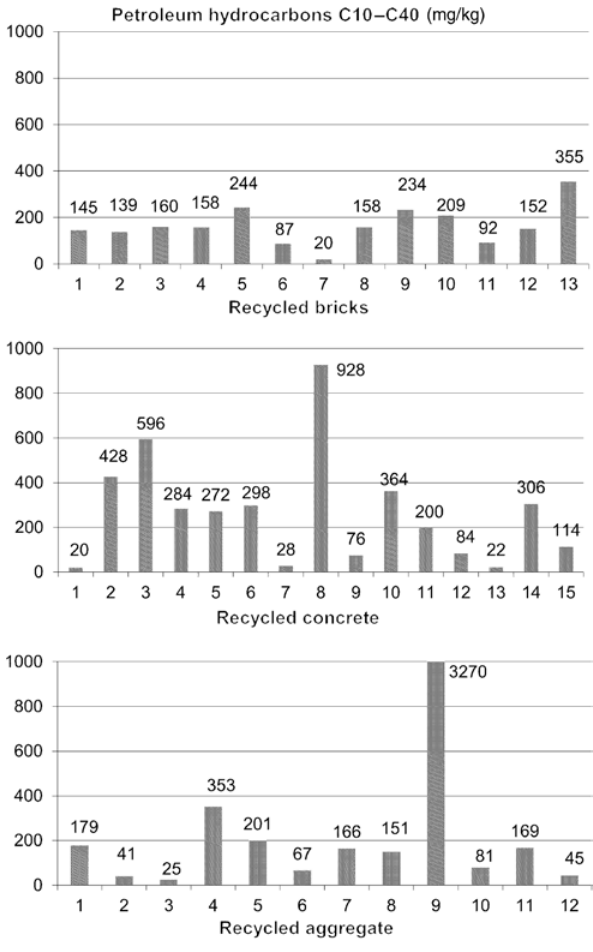
Figure 4: Amount of C10–C40 petroleum hydrocarbons in tested